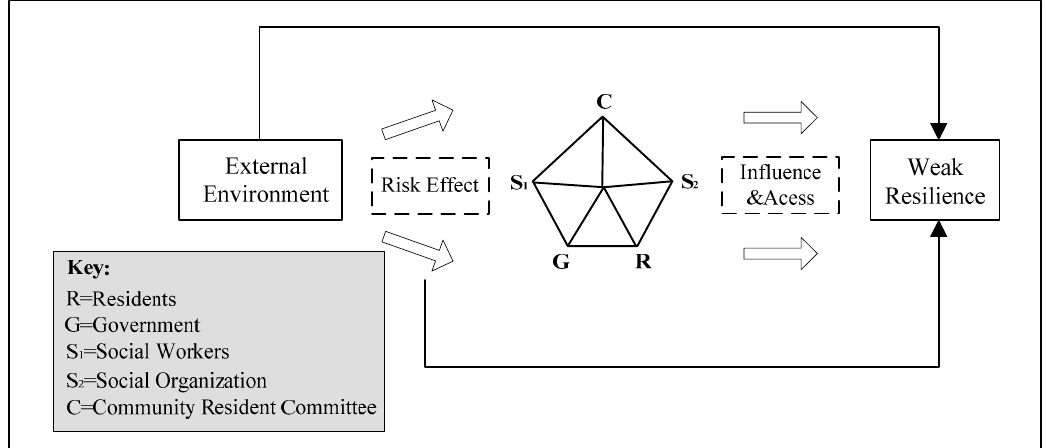
Figure 3. Analytical framework of the formation mechanism of weak resilience of the community public health crisis governance.